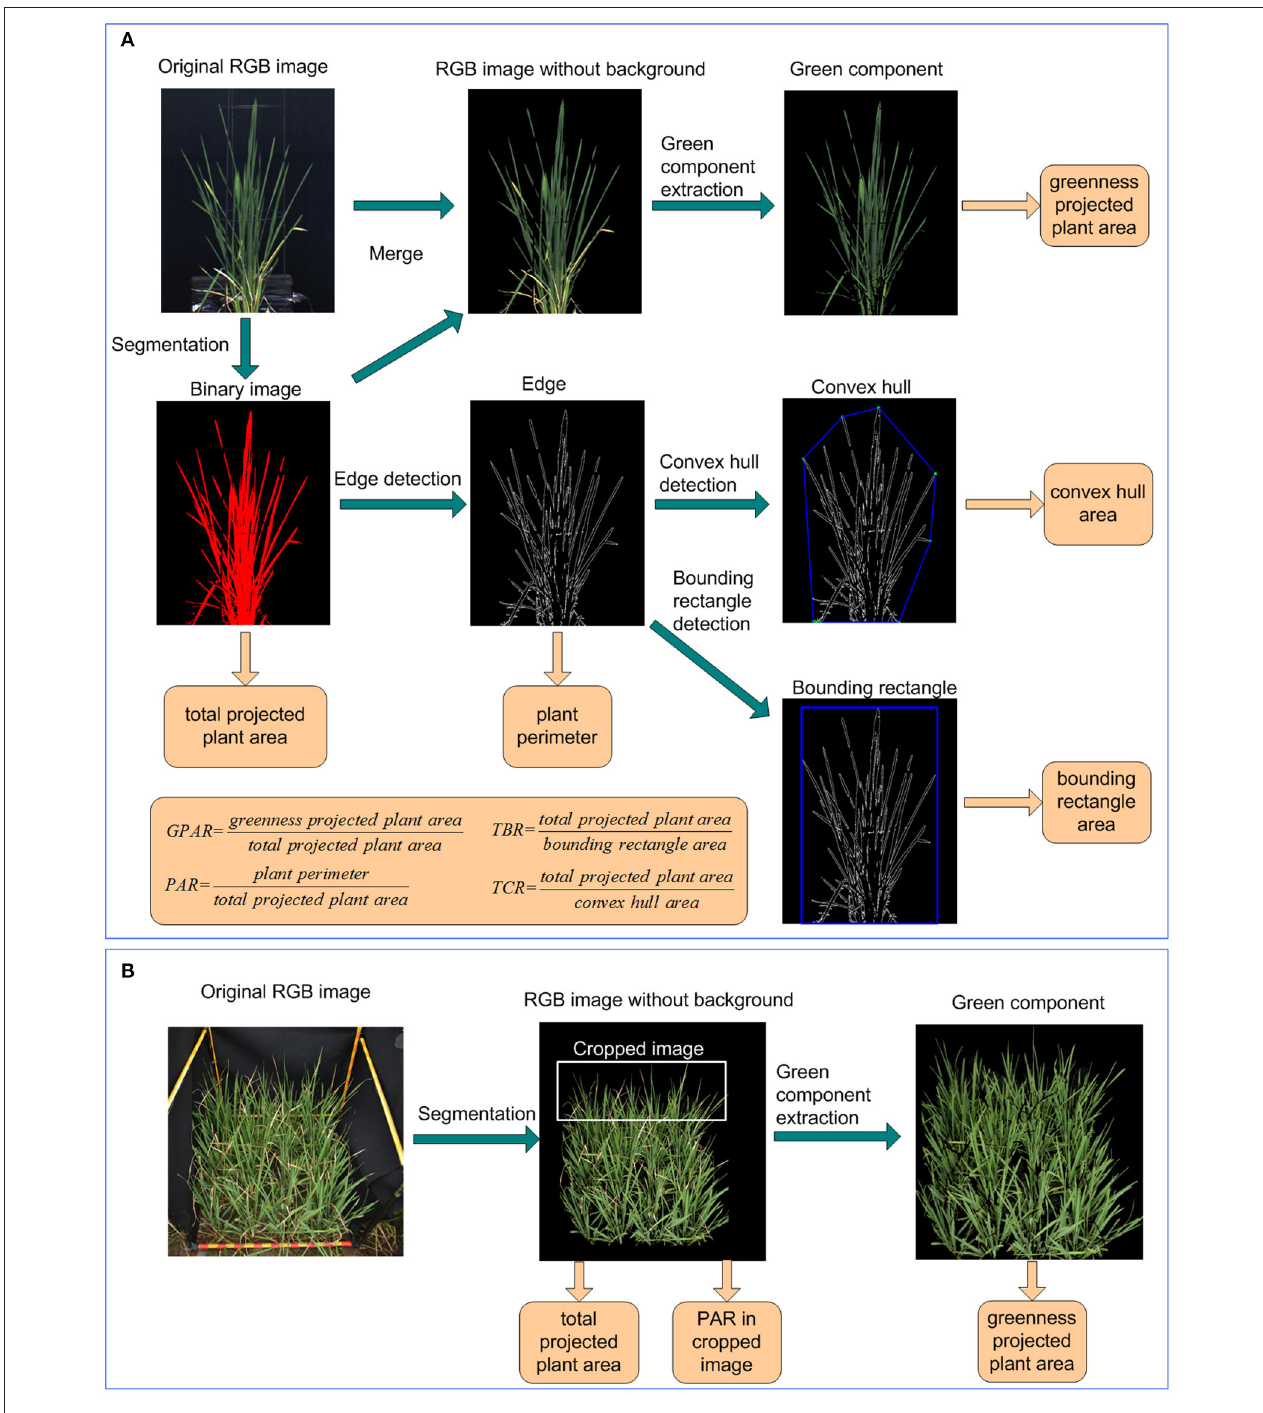
FIGURE 2 | Image analysis and feature extraction pipeline under (A) controlled conditions and (B) field conditions. setting plant pixels as 1 and background pixels as 0. Regions with areas less than a predefined threshold were removed. The number of plant pixels was computed as total projected plant area. (2) Green component extraction and greenness projected plant area calculation: Using the binary image of the